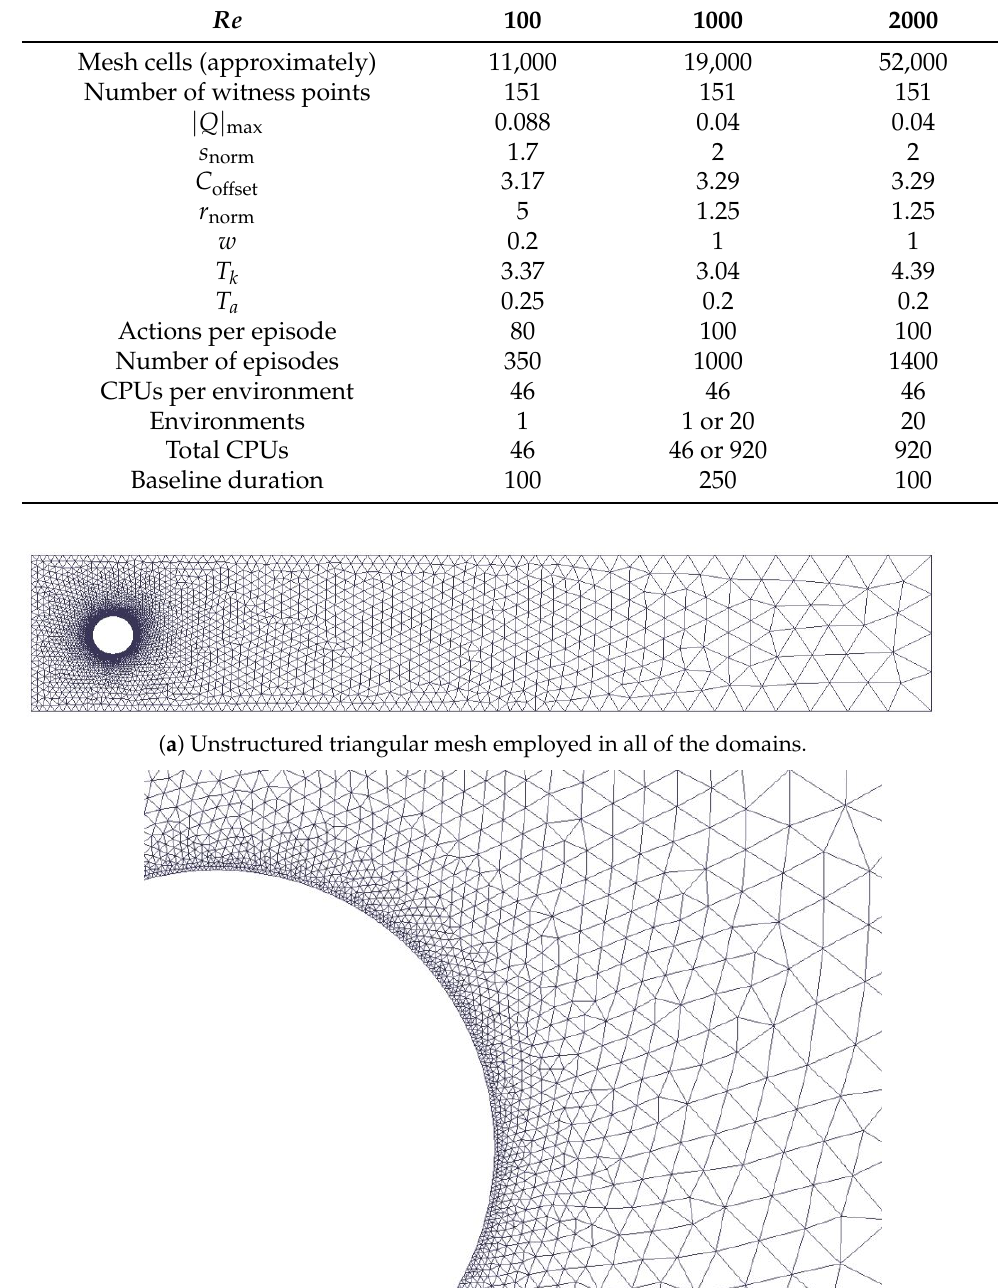
Table 1. Parameters of the simulations for each Reynolds number considered in this work.